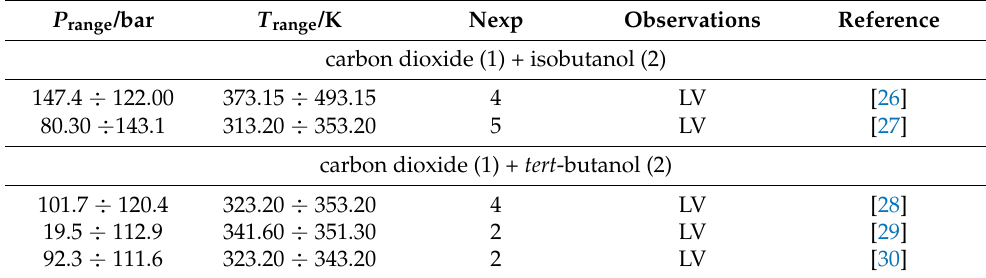
Table 2. Literature experimental critical data for carbon dioxide + isobutanol and + tert -butanol. P range /bar T range